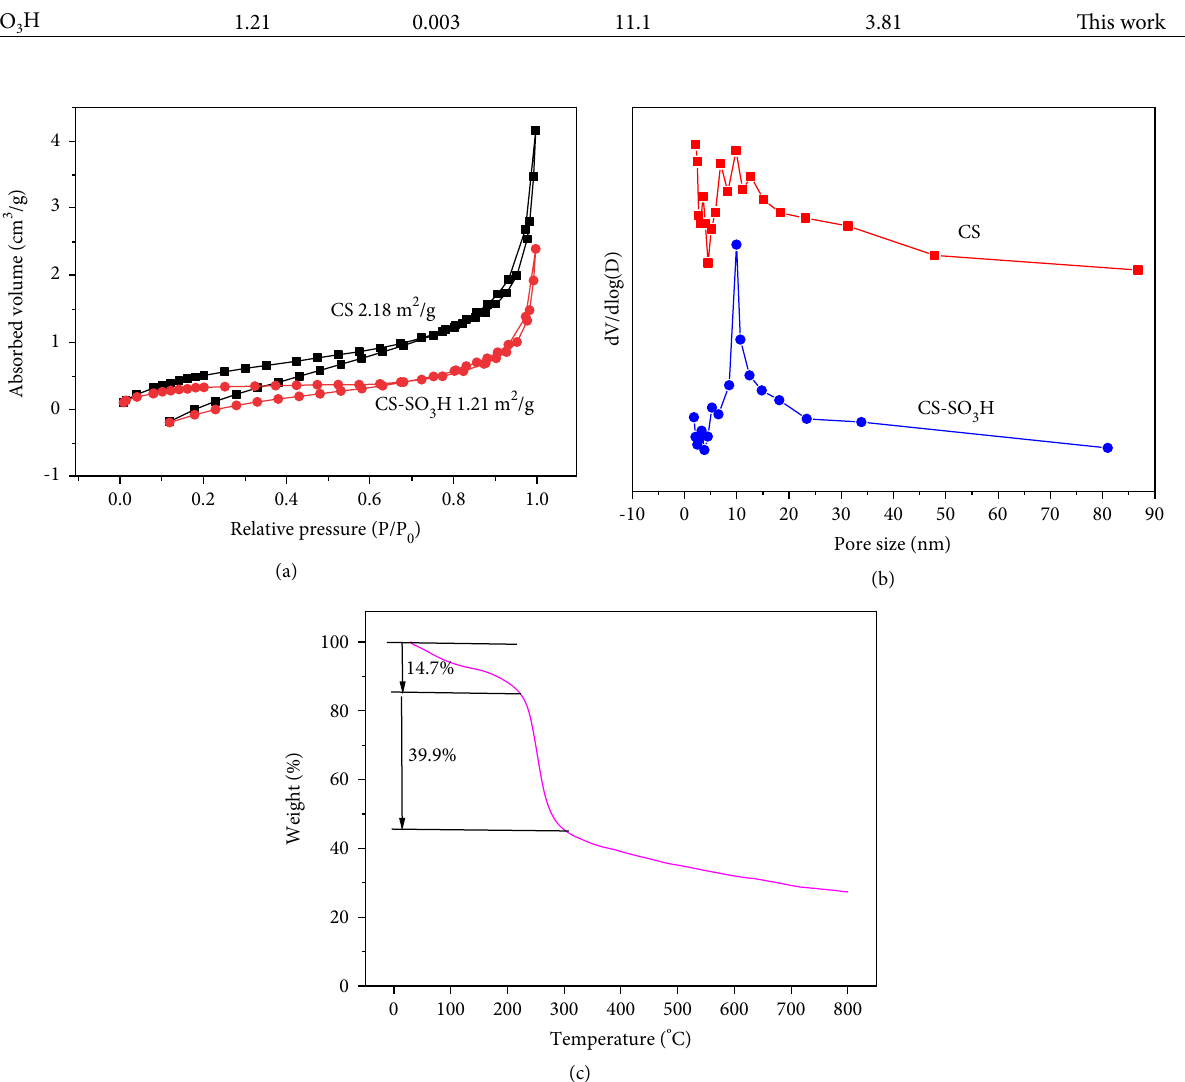
Figure 2: (a) Nitrogen adsorption-desorption isotherms of CS and CS-SO thermogravimetric analysis of the CS-SO